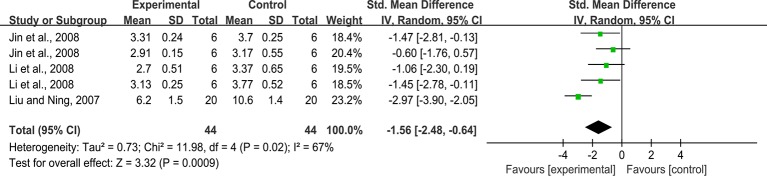
Pooled estimate of kidney tubules injury index with rhein.